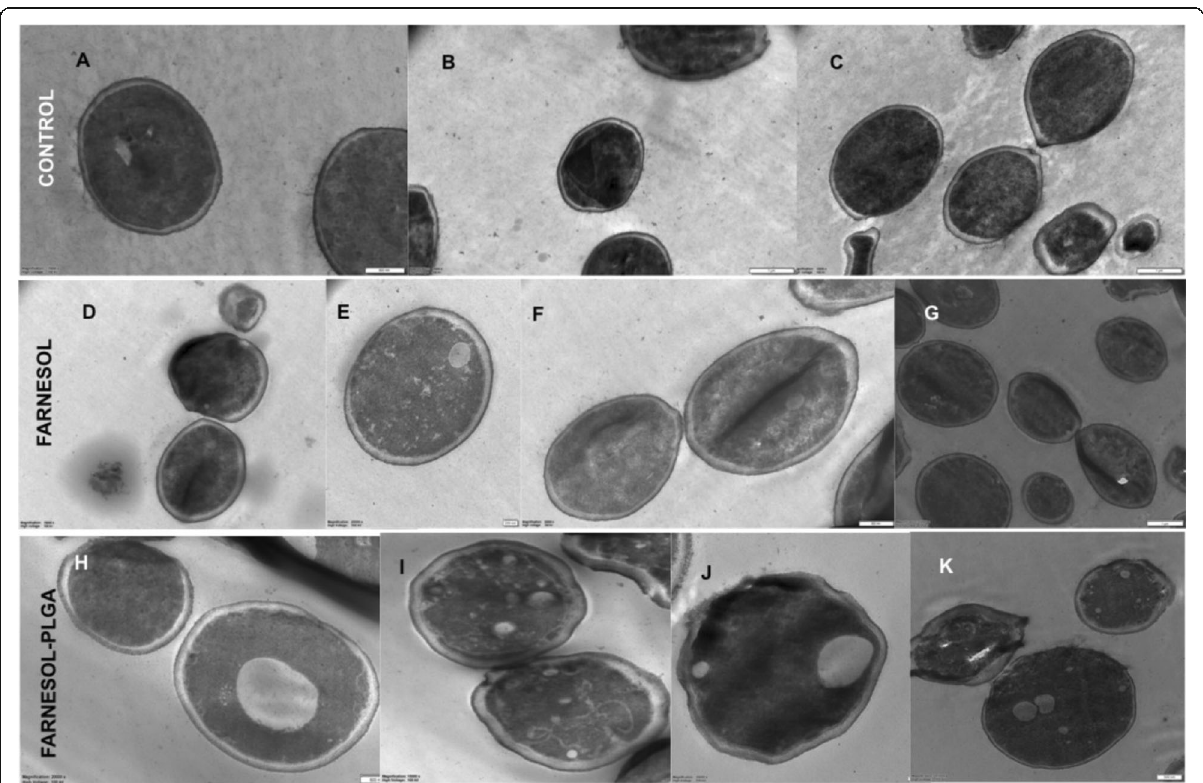
Fig. 5 TEM images of the effects of farnesol and F-PLGA nanoparticles on C. albicans ultrastructure